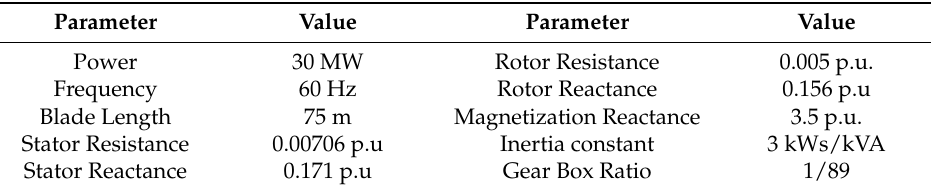
Table 1. DFIG data.